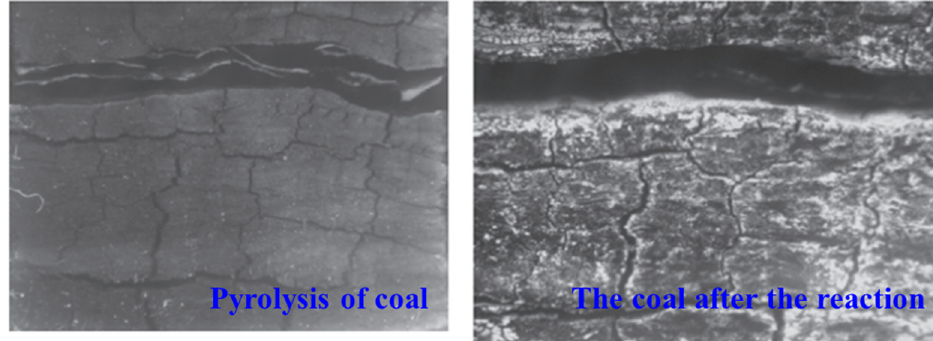
Figure 2. Microscopic images of coal during continuous heating (edited from [17]).